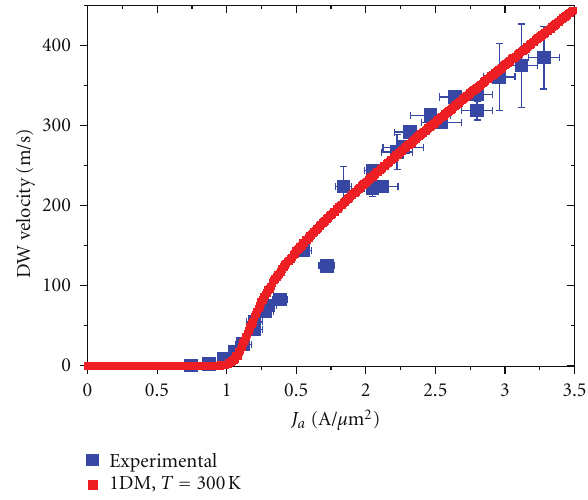
Figure 6: Comparison of the experimental results (see Figure 3 in [55]) and 1DM predictions for the current-induced DW dynamics along a Cobalt strip with high PMA sandwiched between two dissimilar nonmagnetic strips (Pt/Co/AlO) at room temperature ( T = 300K). All the 1 DM parameters are enumerated in the